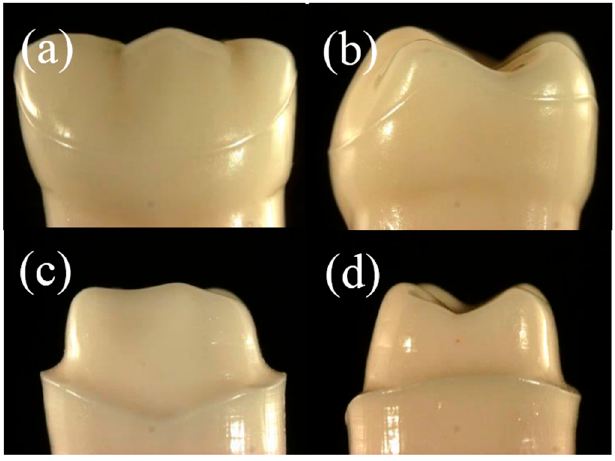
Figure 1. Photographs of the artificial tooth before tooth preparation ( a , b ) and after tooth preparation for all-ceramic restorations ( c , d ).